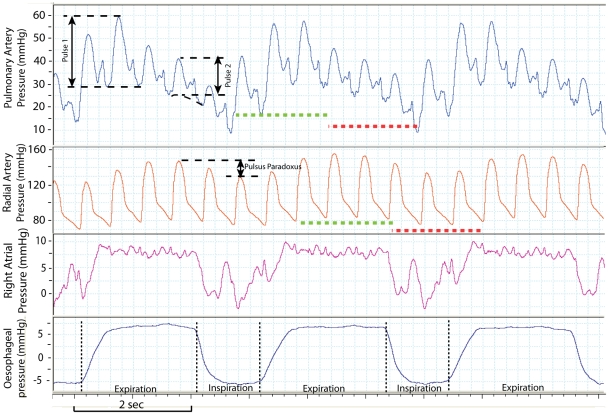
Example of the behavior of the pulmonary artery pressure over the respiratory cycle in a COPD patient.In the upper channel we show the decline in pulse pressure (pulse 1 - pulse 2) in the pulmonary artery during expiration, which is a consistent phenomenon over all respiratory cycles. The second channel shows the pressure in the radial artery. The decline in pulse pressure in the radial artery seems to follow the decline in the pulmonary artery pressure. (red dotted lines). During expiration, the intrathoracic pressure (channel 4) probably exceeds the central venous pressure, which would explain the flat line of the right atrial pressure (channel 3).